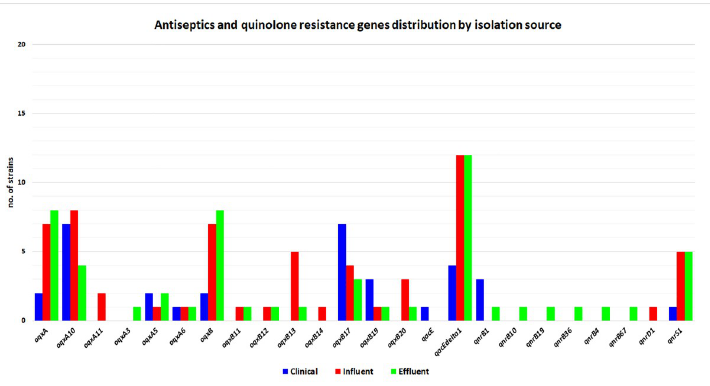
Fig 3. Identified quinolone and antiseptics resistance genes in wastewater and clinical